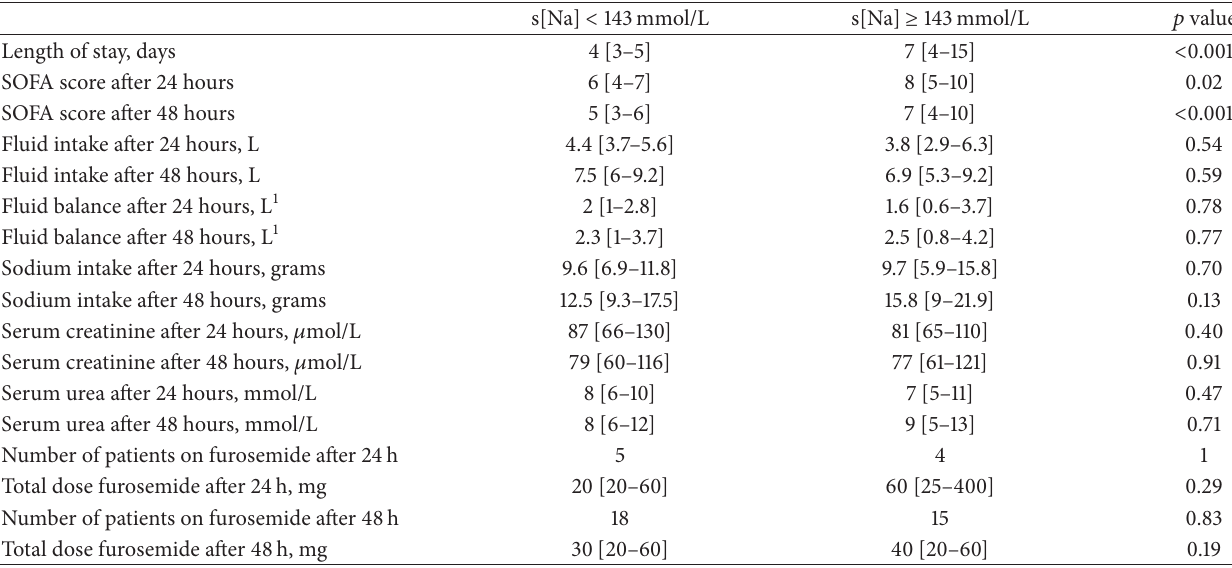
Table 2: Main results balance study.